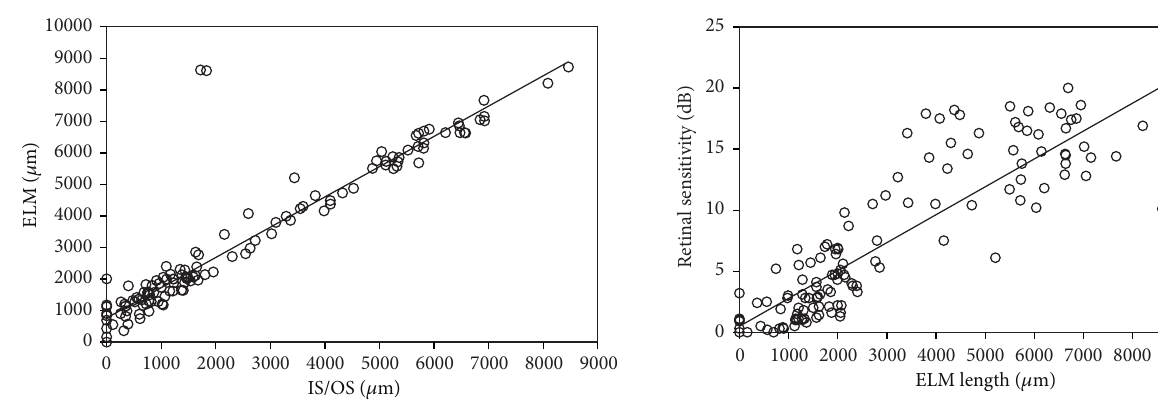
Figure 3: Correlation between the lengths of the photoreceptor inner/outer segment (IS/OS) junction and the external limiting membrane (ELM) lines in 133 eyes with retinitis pigmentosa. There is a significant positive correlation between the lengths of the IS/OS and ELM lines ( 𝑟 = 0.933 , 𝑃 < 0.0001 ). The solid line represents the linear regression curve (𝑦 = 768.13 + 0.96𝑥) .